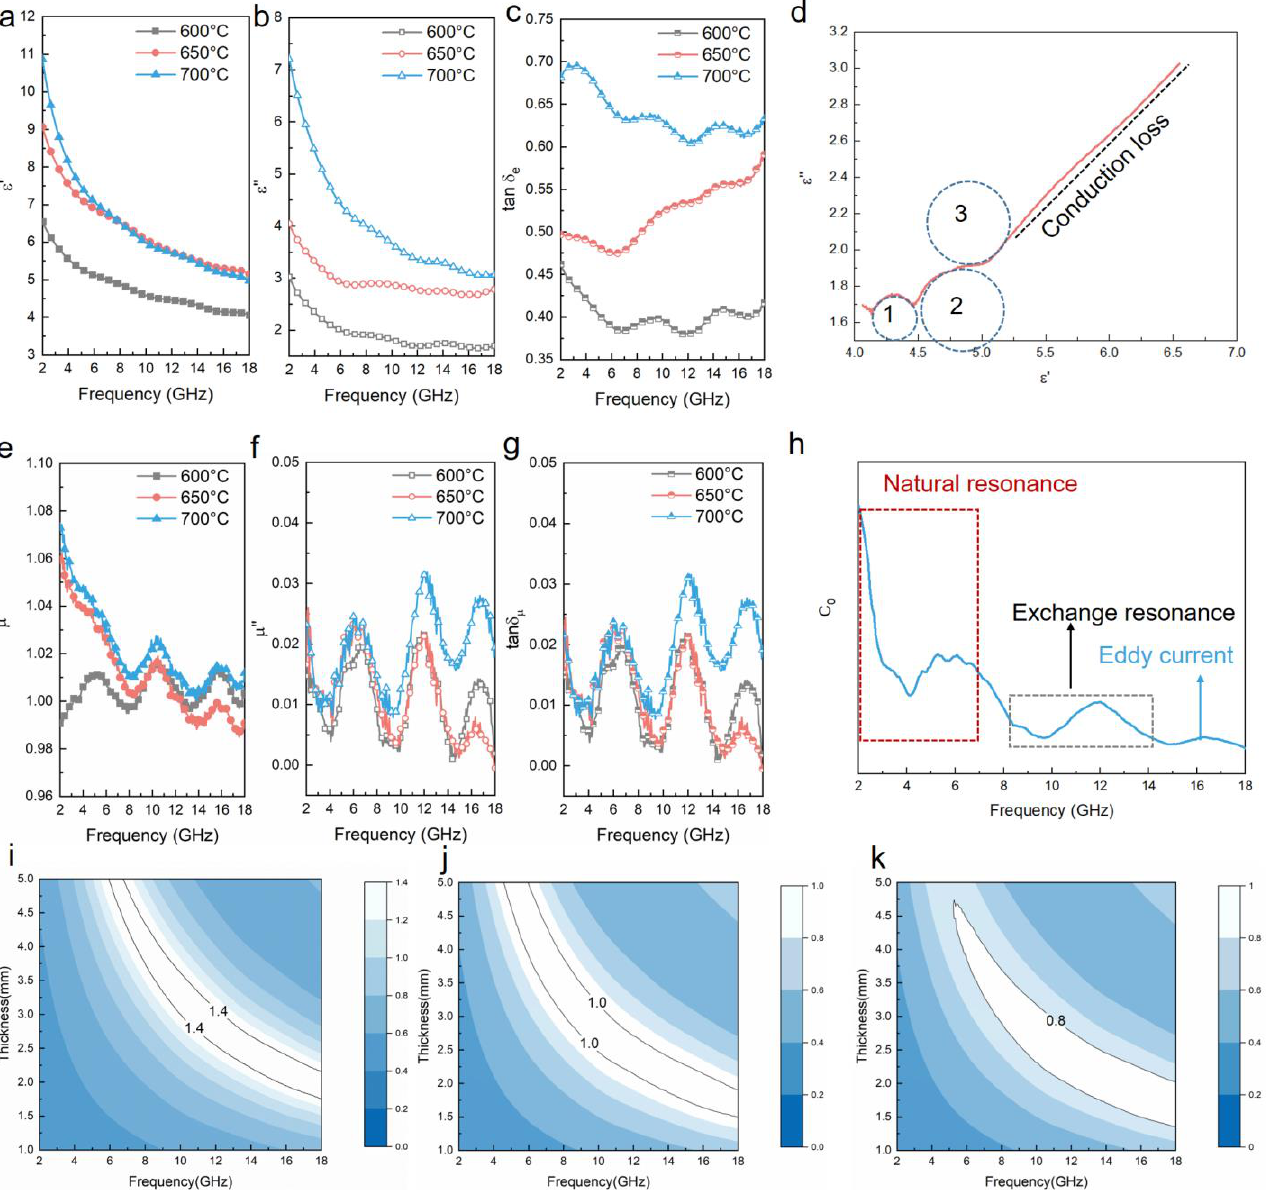
Figure 6. ( a ) Real parts (ε′), ( b ) imaginary parts (ε′′) of complex permittivity, ( c ) dielectric loss tangent values (tanδ ε ), ( e ) real parts (μ′) and ( f ) imaginary parts (μ′′) of complex permeability, and ( g ) magnetic loss tangent values (tanδ μ ) of Ni 3 S 2 @NSGA samples. ( d ) Cole – Cole semicircle curve and ( h ) e C 0 -f curve of Ni 3 S 2 @NSGA-650. ( i – k ) 2D contour maps of |Z in /Z 0 | at different thicknesses from 2 to 18 GHz for Ni 3 S 2 @NSGA